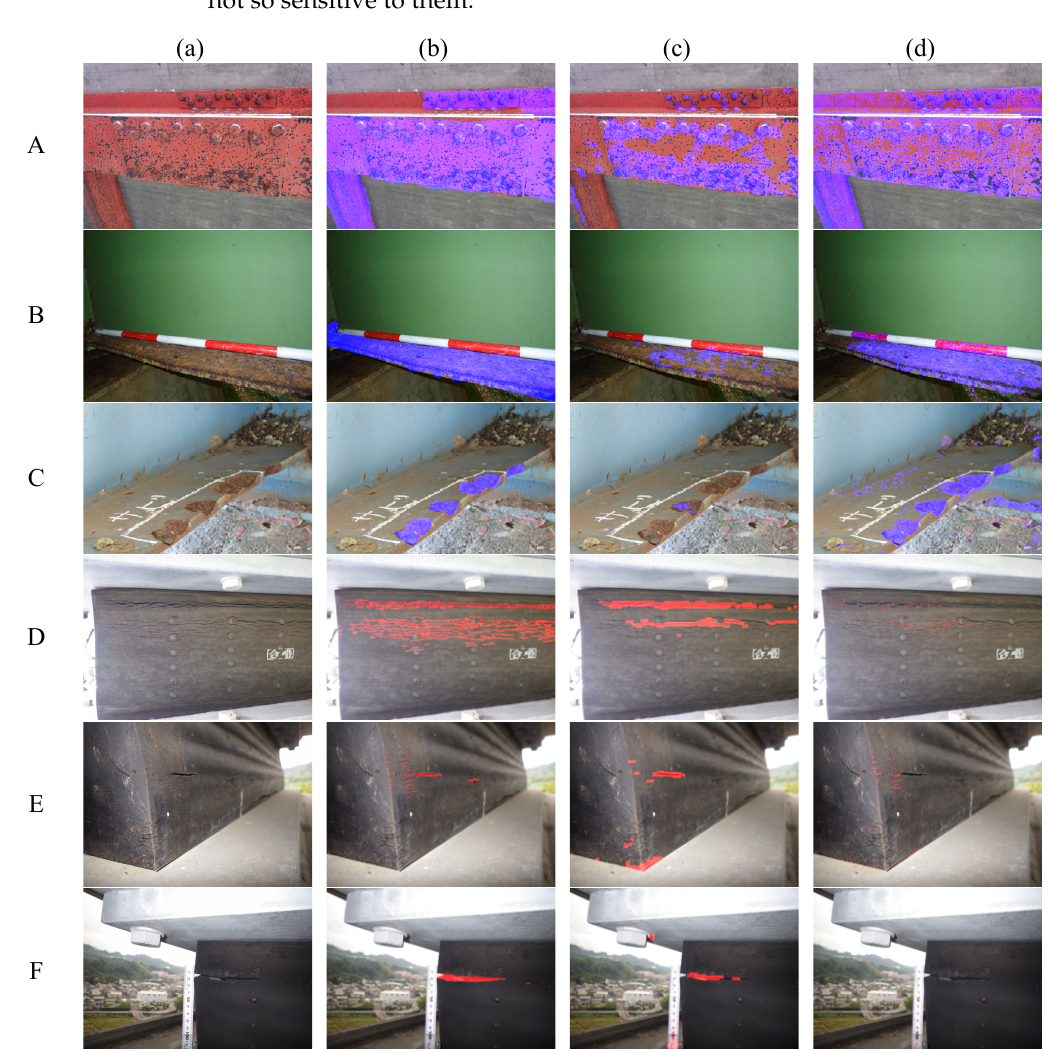
Figure 10. Prediction results: ( a ) original images, ( b ) ground truth, ( c ) Squashing Segmentation results, ( d ) Cropping Fig.9 Prediction results: (a) original images, (b) ground truth, (c) Squashing Segmentation results, Segmentation